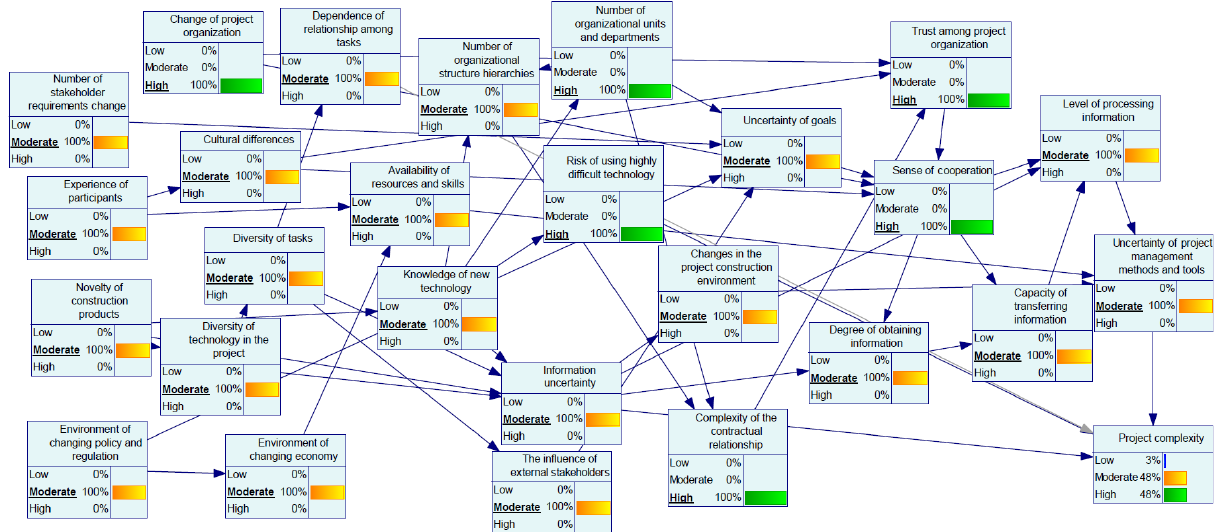
Figure 10. Project complexity measurement result of the EXPO 2010 Shanghai China